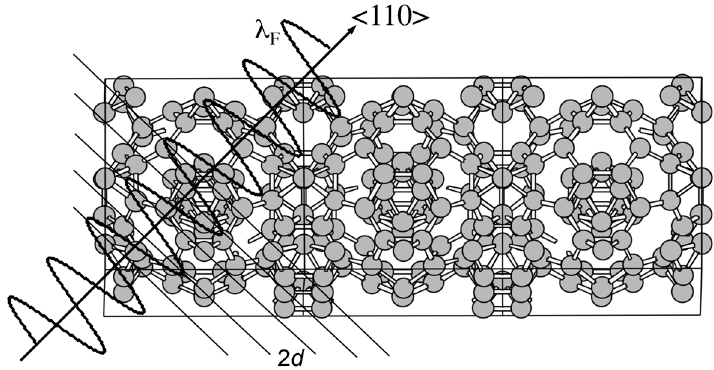
Figure 4. Formation of stationary electron waves as a result of interference with periodically arranged ionic potentials [11,14,19].